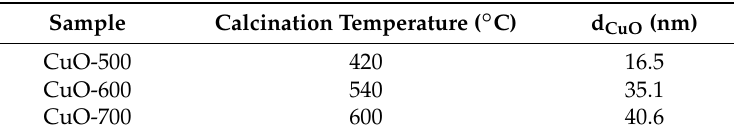
Table 3. Properties of pure